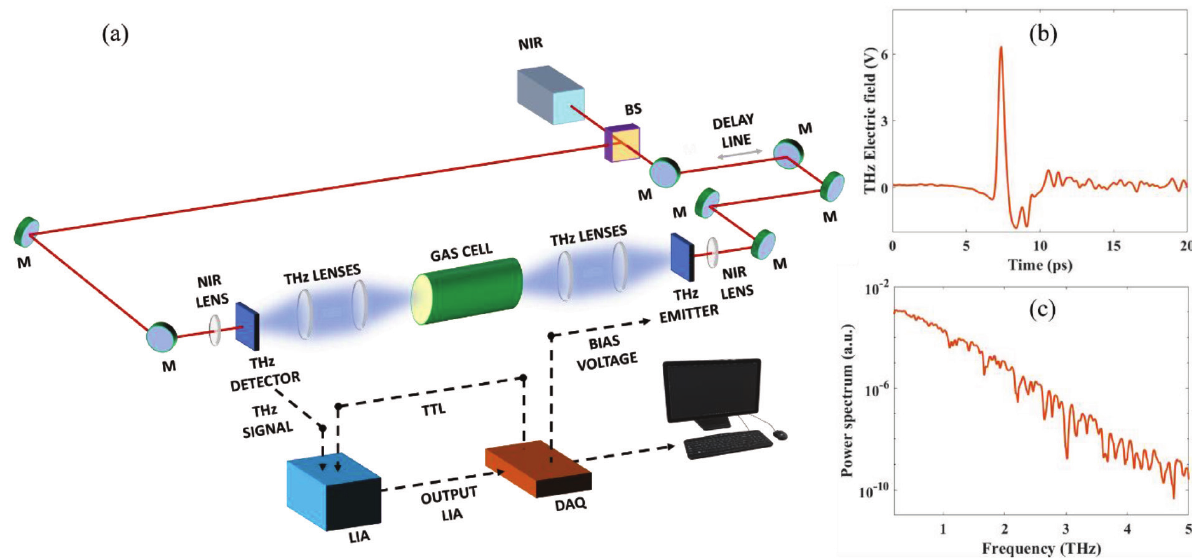
Figure 4: (a) Schematic layout of a typical THz-TDS setup in transmission mode based on switched photoconductive antennas (PCAs). A femtosecond near-IR (NIR) laser beam is divided in two parts by a beam splitter. Some mirrors ( M ) convey the laser beams to the THz